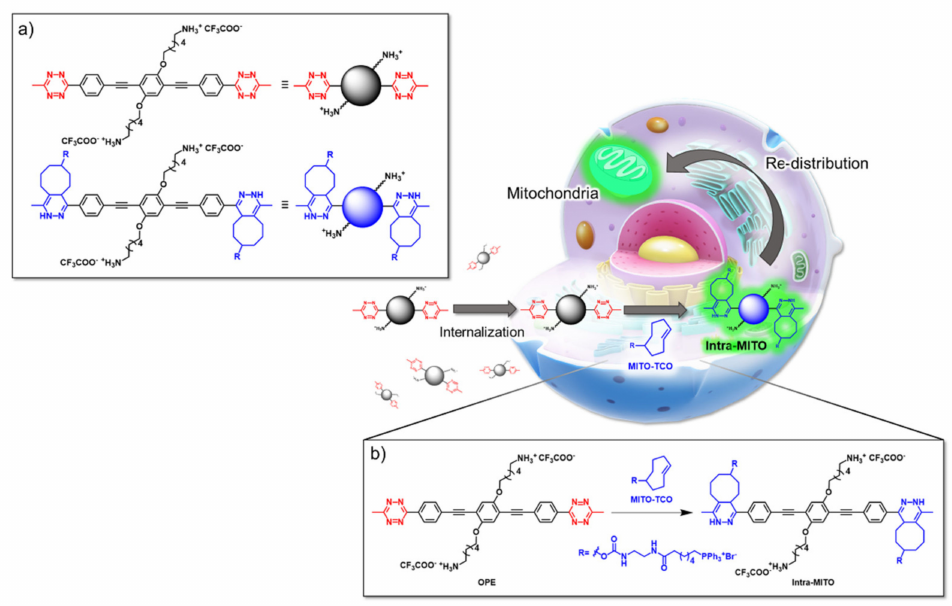
Figure 2. Schematic illustration of the mitochondria-targeting process of tetrazine-conjugated OPE 15 in living cells: ( a ) the simplified representation of OPEs 15 and 16 ; ( b ) the intracellular synthesis of fluorescent